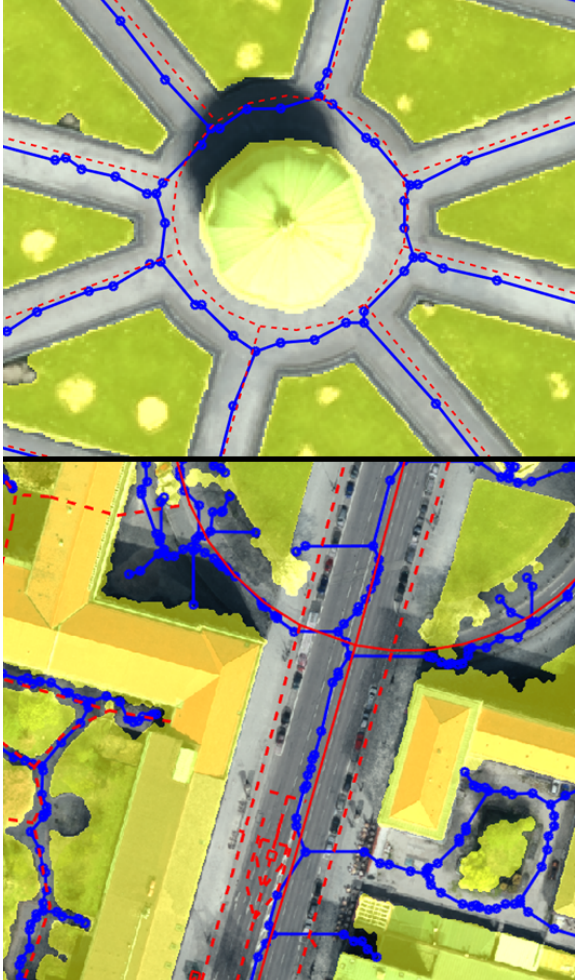
Figure 2: Detailed view of the classification results, where non- road class is emphasized by golden color, the input polylines, in blue, and the “ground truth” represented by the content of the OpenStreetMap shapefile, in red. Here, main and auxiliary roads are depicted by solid and dashed lines,